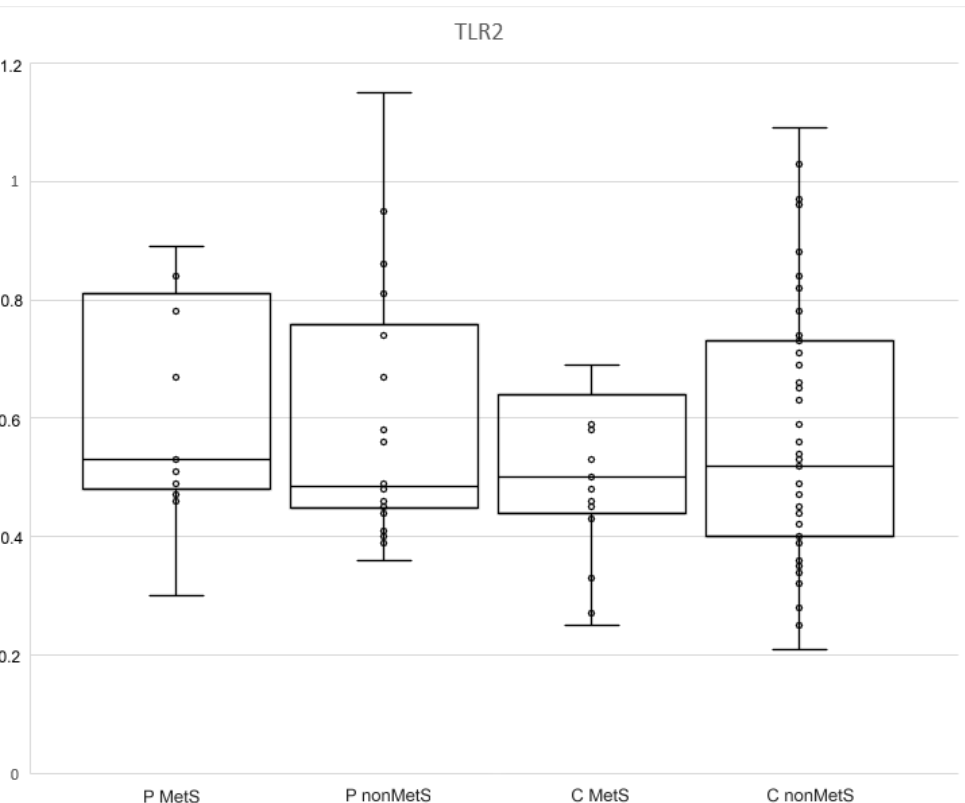
The differences between the levels of TLR2 in controls and patients and in all sub- groups were not statistically significant (Tables 4 and 5; Figure 4).